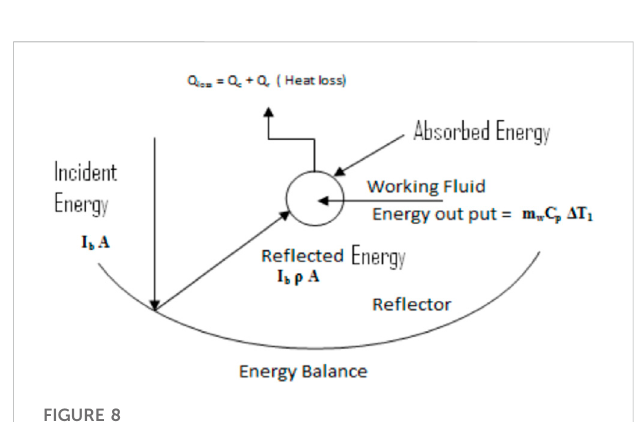
FIGURE 8 Energy balance of the cycloidal